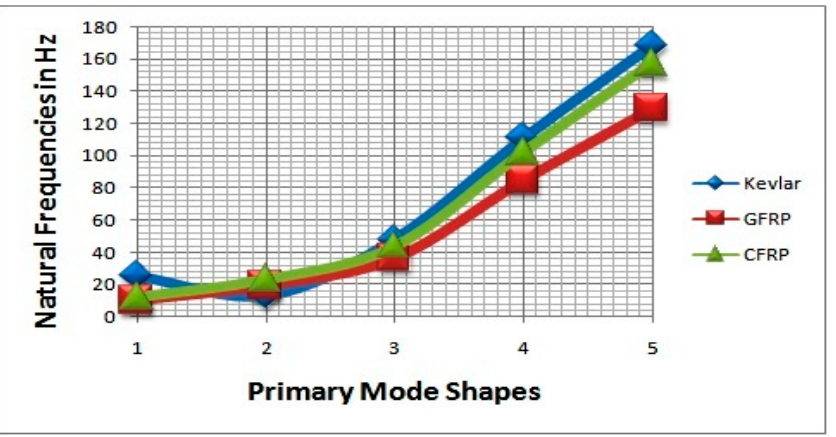
Figure 21. Comprehensive details of linear mode shapes versus natural frequencies for different alloys—Wind Turbine Blade.